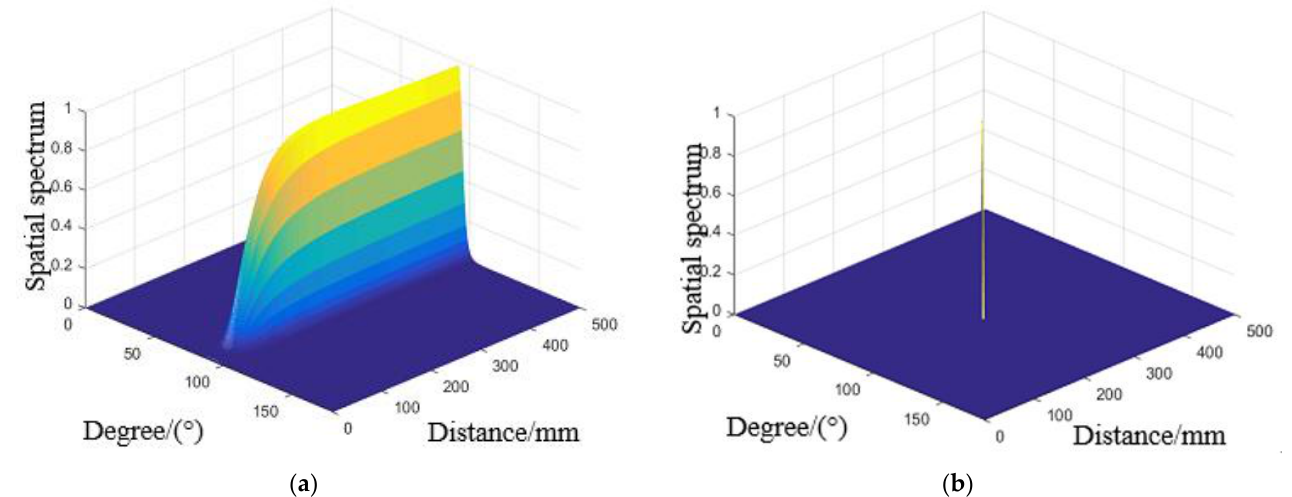
Figure 12. Spatial spectrum estimated for 50 °C by ( a ) Stander 2D-MUSIC ( b ) Compensated 2D-MUSIC.